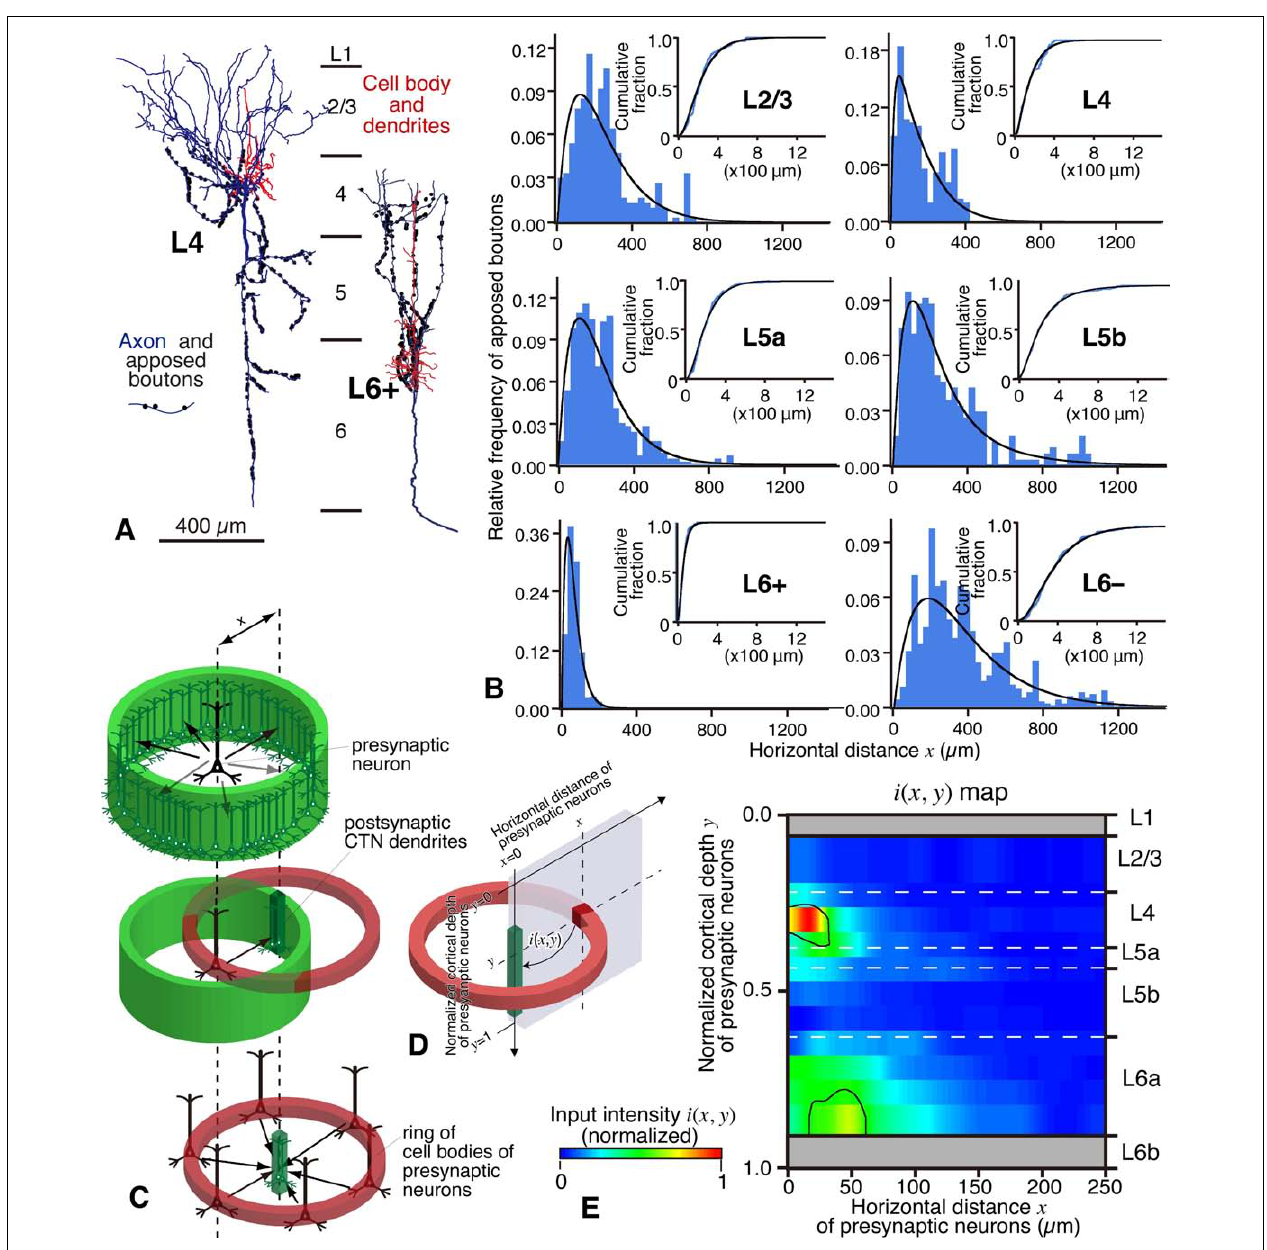
FIGURE 9 | Local excitatory inputs toVP-projecting CTNs in rat areas S1, HL, and FL. (A) Single L4 star-pyramidal and L6 + pyramidal neurons sent many apposed boutons to CTNs. (B) The horizontal distribution (fitted with a gamma distribution) of the apposed boutons of representative neurons were different from layer to layer. L4 spiny and L6 + pyramidal neurons sent apposed boutons to CTN dendrites that were located in a narrow range, whereas L5 and L6 − neurons projected them to CTN dendrites that spread horizontally. (C,D) From the original data in (B) , the number of apposed boutons arising from an average presynaptic neuron as a function of horizontal distance x is obtained ( C , top) under the assumption that cortical excitatory neurons sending axons to CTN dendrites are distributed homogeneously in horizontal directions at a given depth ( y ).When the presynaptic neuron sends a certain amount of apposed boutons to postsynaptic CTN dendrites in a given unit volume (slender dense green square prism in C , middle), the CTN dendrites are expected to receive the